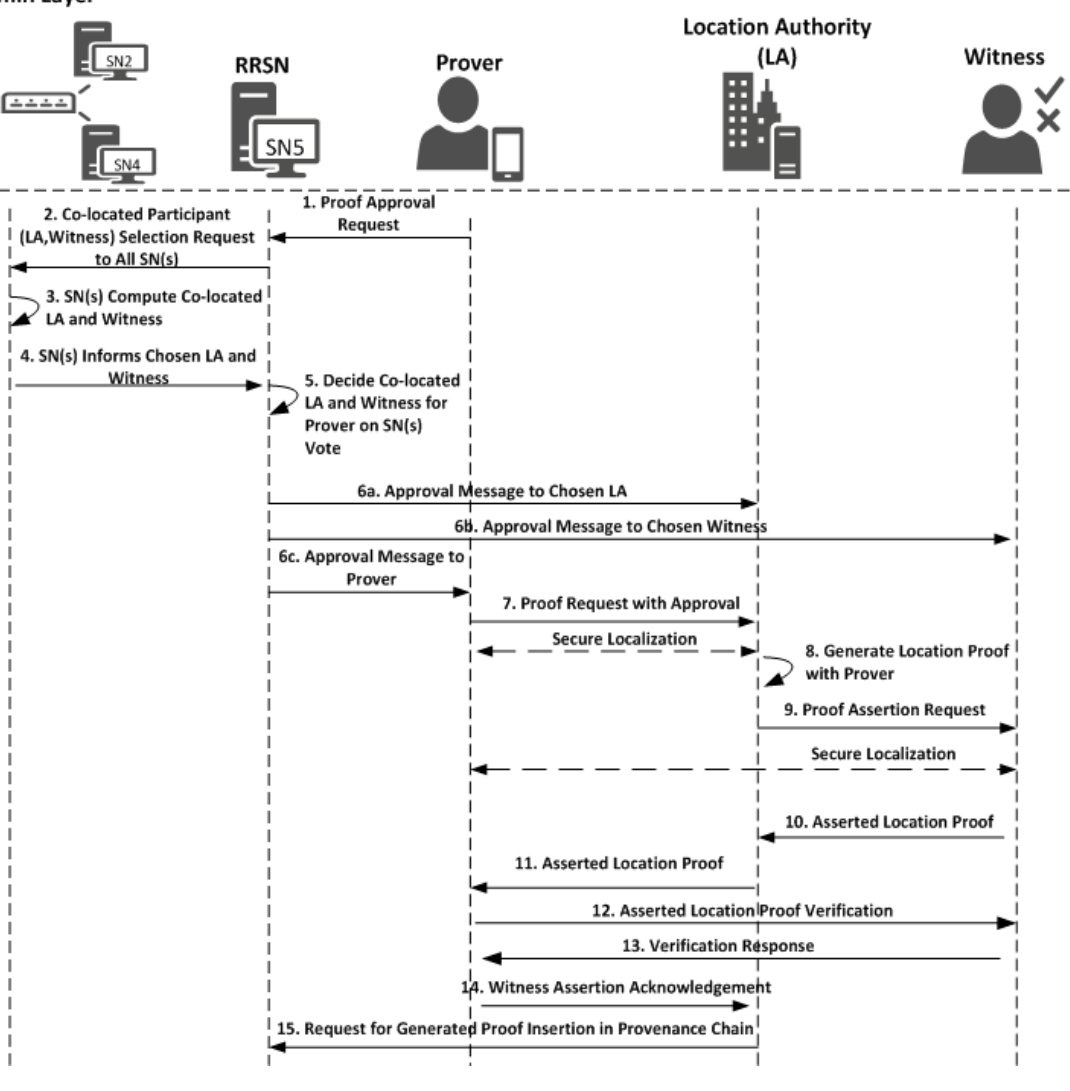
Figure 2. Witness ‐ oriented location proof protocol. Figure 2. Witness-oriented location proof